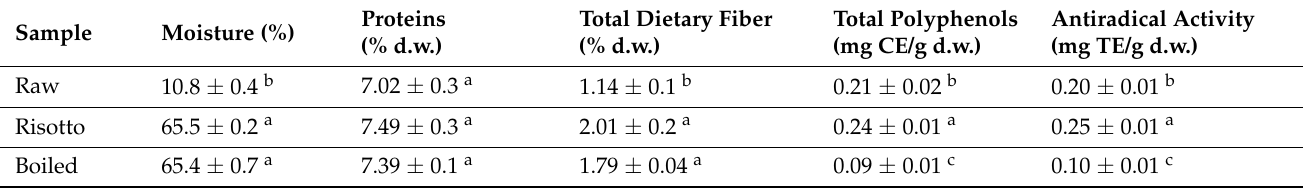
Table 2. Proximate composition, total phenolic content (mg CE/g d.w.), and total antioxidant activity (mg TE/g d.w.) determined in raw and cooked “Gigante Vercelli” white rice.